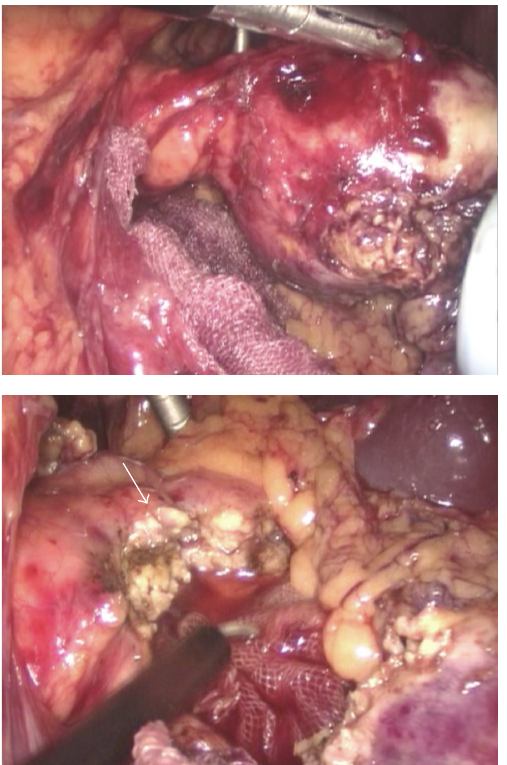
Figure 3: Intraoperative findings and surgical procedure. Above: tumor was grasped by forceps. Tumor was confirmed to be well demarcated and protruded from the pancreas tail. Peritoneal dis- semination was not seen on laparoscopic exploration. Below: the tumor was resected with small amount of pancreatic parenchyma. Pancreatic parenchyma was divided by using laparoscopic coagula- tion shears. Arrow shows the cut surface of the